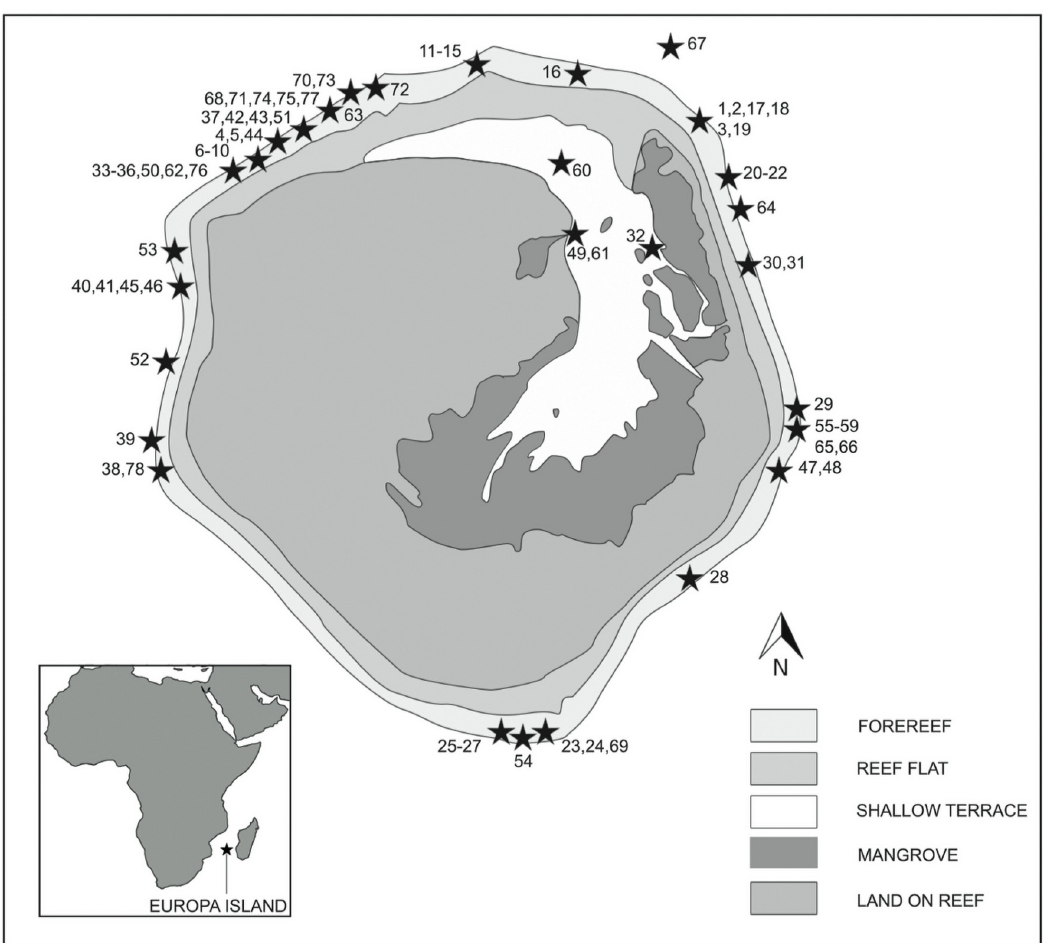
Fig 1. Europa Island. Site location on the forereef and in the lagoon, adapted from https://eol.jsc.nasa.gov/SearchPhotos/photo.pl? mission=ISS005&roll=E&frame=9408 using Adobe Illustrator. Inset shows the position of Europa between Africa and Madagascar, composed using QGIS (version 3.4.6